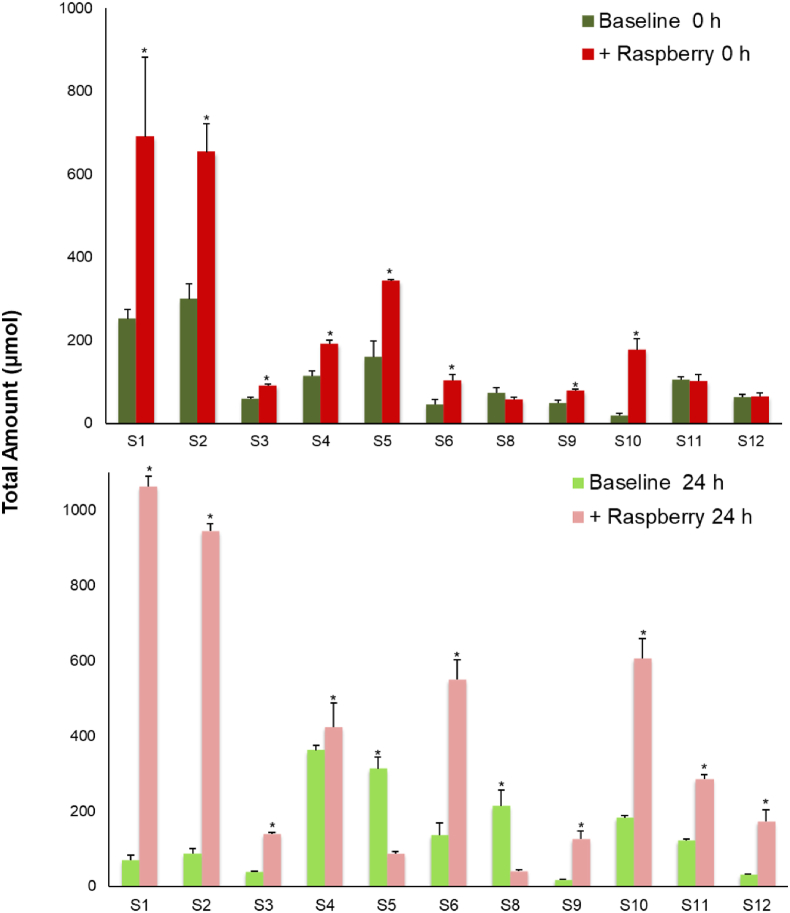
The impact of fecal fermentation on the total amount of phenolic acid and aromatic catabolites in ileal fluid collected before (Baseline) and after the consumption of 300 g of raspberry puree (+Raspberry) by 12 subjects. Baseline and +Raspberry samples before fecal fermentation (0 h). Baseline and +Raspberry samples after 24 h fecal fermentation (24 h). Significance compared for each subject between pre- and post-berry intake using One-way ANOVA and Dunnett T test, *p < 0.05.